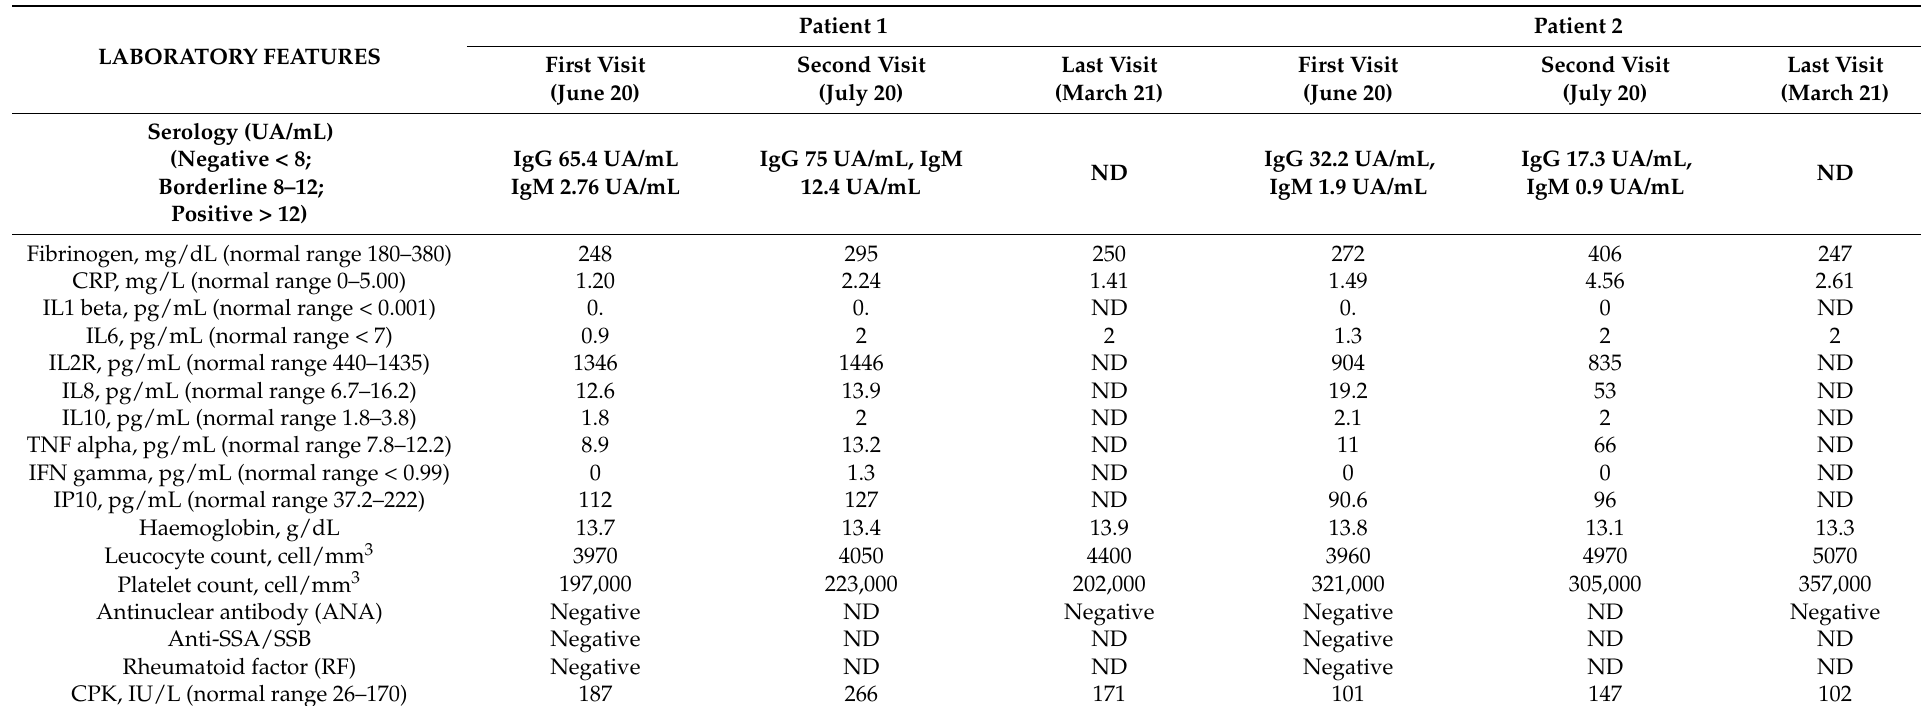
Table 2. Laboratory features at sacroiliitis diagnosis and during follow-up at our